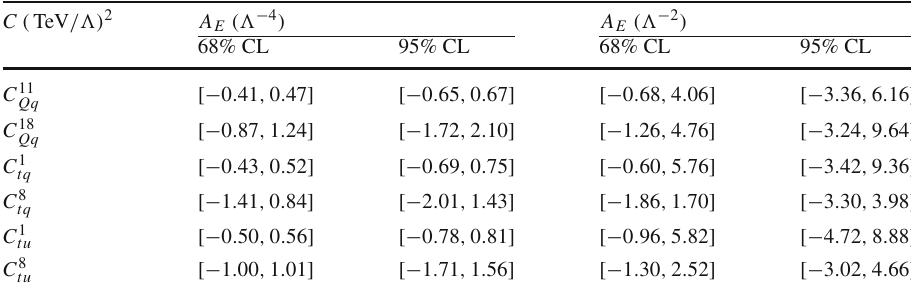
, A 2 , and A 3 . E E E